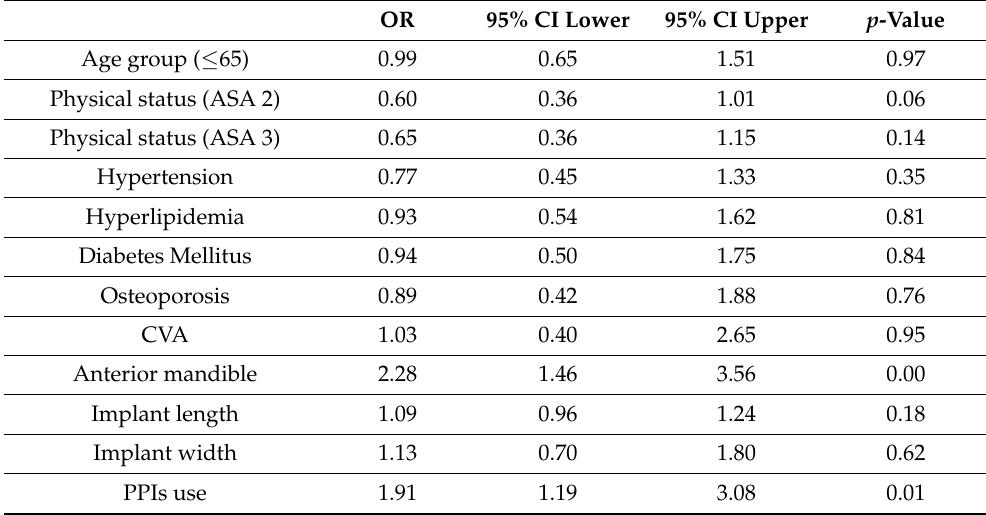
Table 3. Binary Logistic regression coefficients (at the implant level) to predict implant failure.